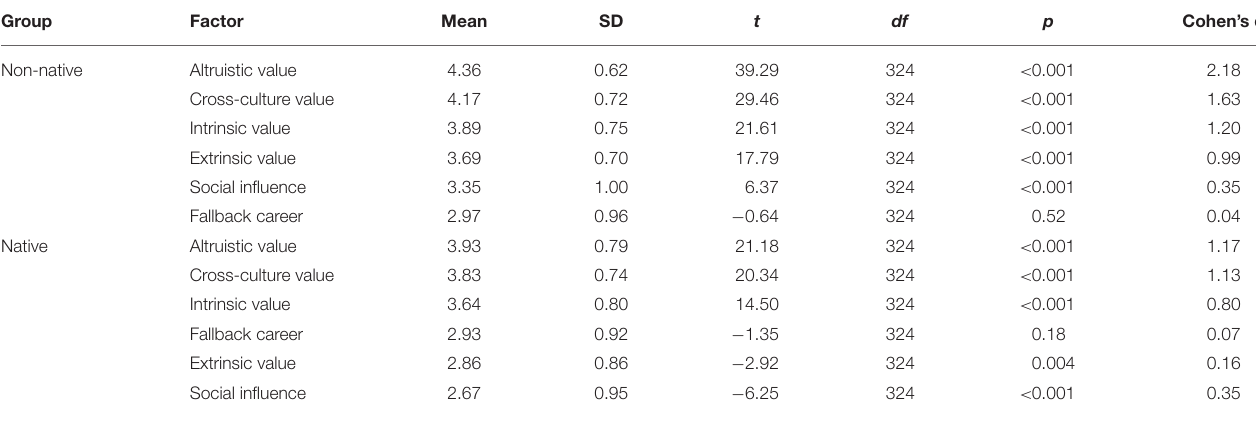
TABLE 6 | Summary of the ratings of the native and non-native groups in each factor and the results of one-sample t -tests.